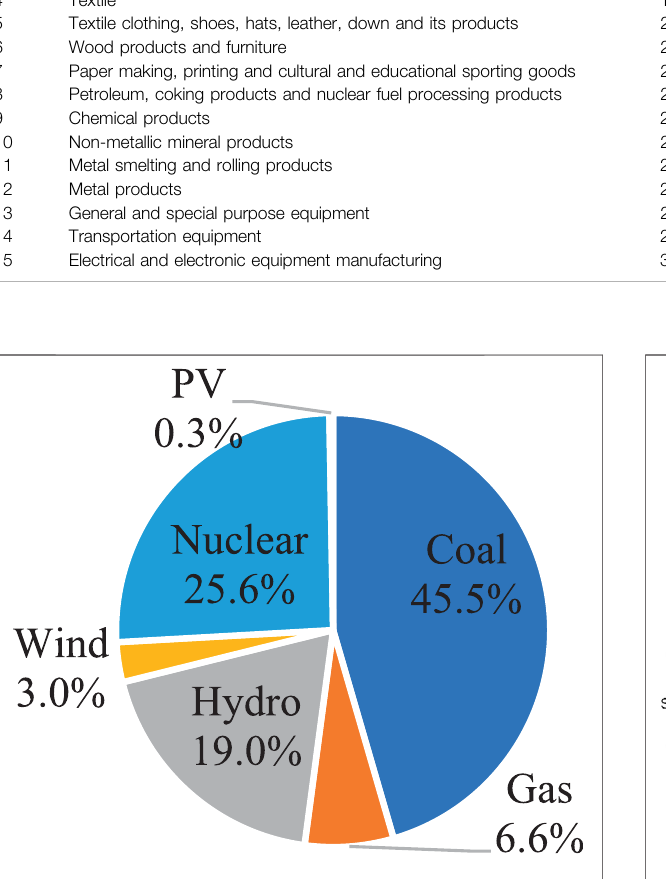
FIGURE 3 | Fujian ’ s power generation structure in 2017.